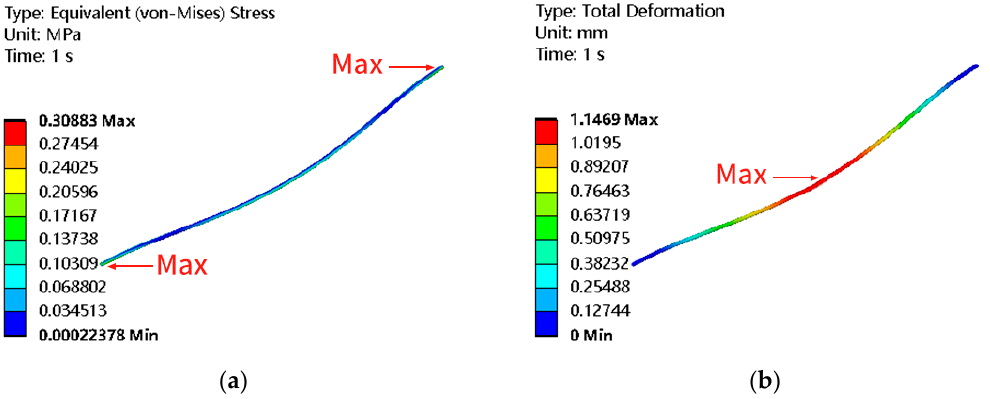
Figure 7. Cloud diagram of total deformation and equivalence force distribution (length 200 mm, air velocity 3 m/s). ( a ) Equivalent stress (MPa); ( b ) Total deformation (mm).